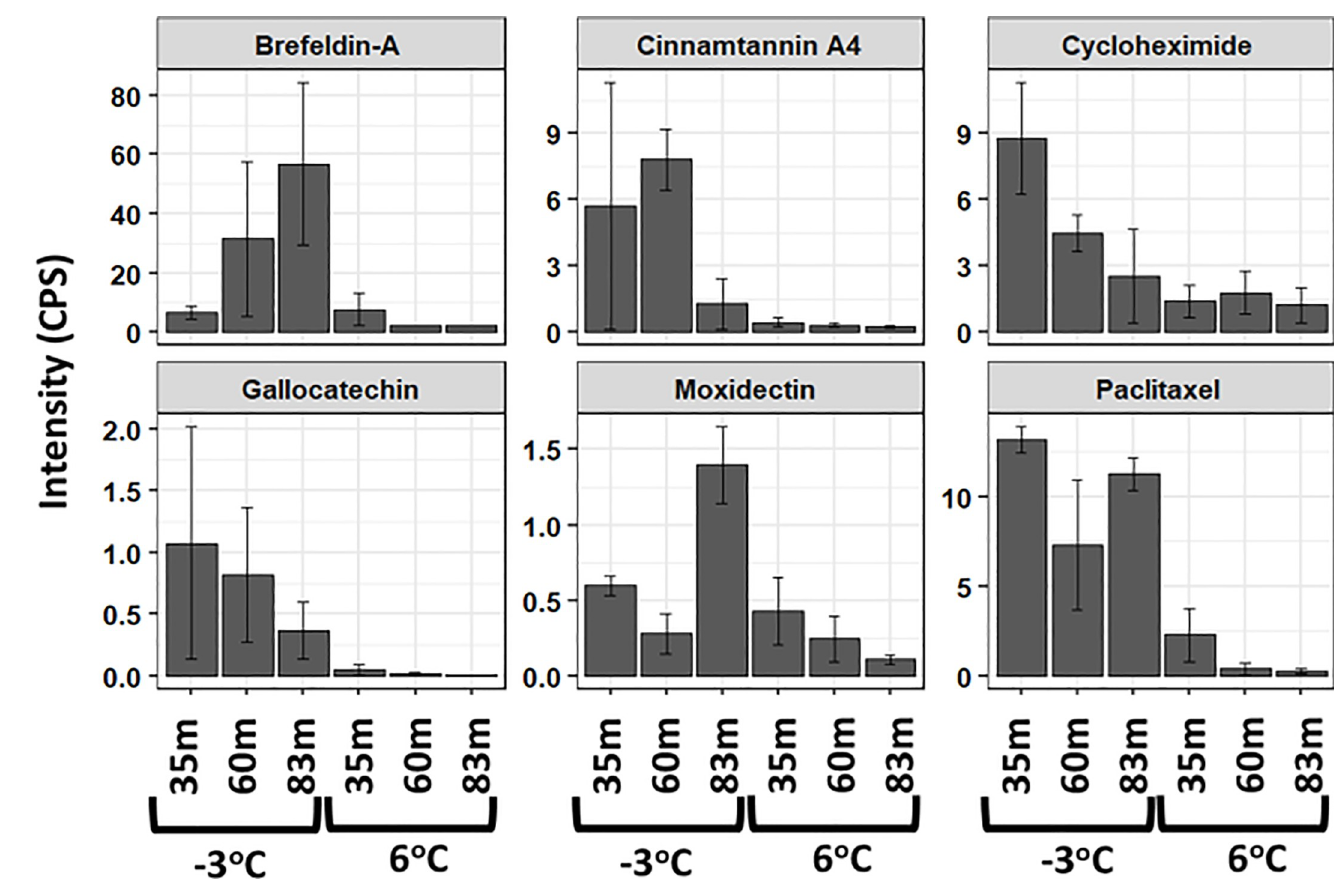
Fig 6. A bar chart of the significant metabolites driving discrimination groups in the PCA scores with their respective standard error over three replicates in the ESI+ mode. Important metabolites were identified as the top 10% of the PCA loadings in the filtered